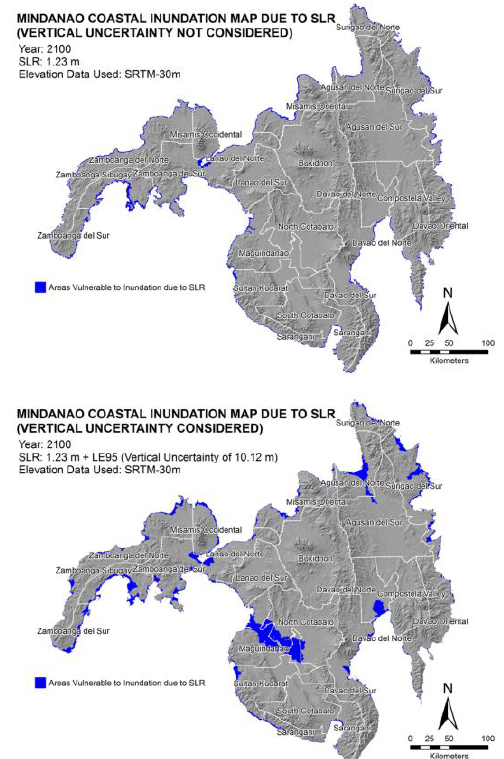
Figure 6. Map of inundations due to SLR of 1.23 using SRTM 30-m DEM with and without considerations of vertical uncertainties computed using all GCPs. Figure 7. Effects of GCP order accuracy to the vertical accuracies and uncertainties of the